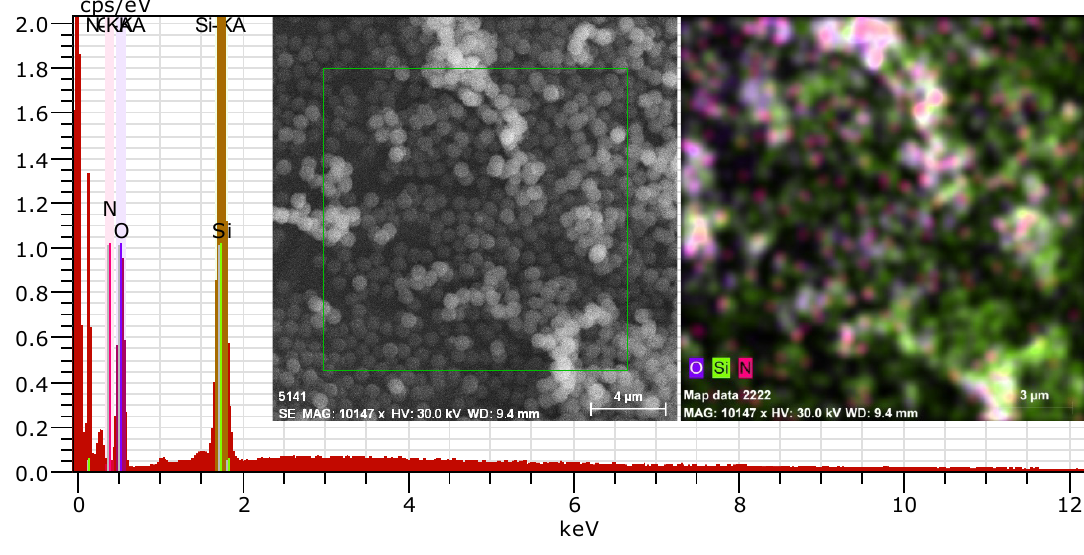
@Cr(VI)-IIL, shown in the inset with an EDS map. 2